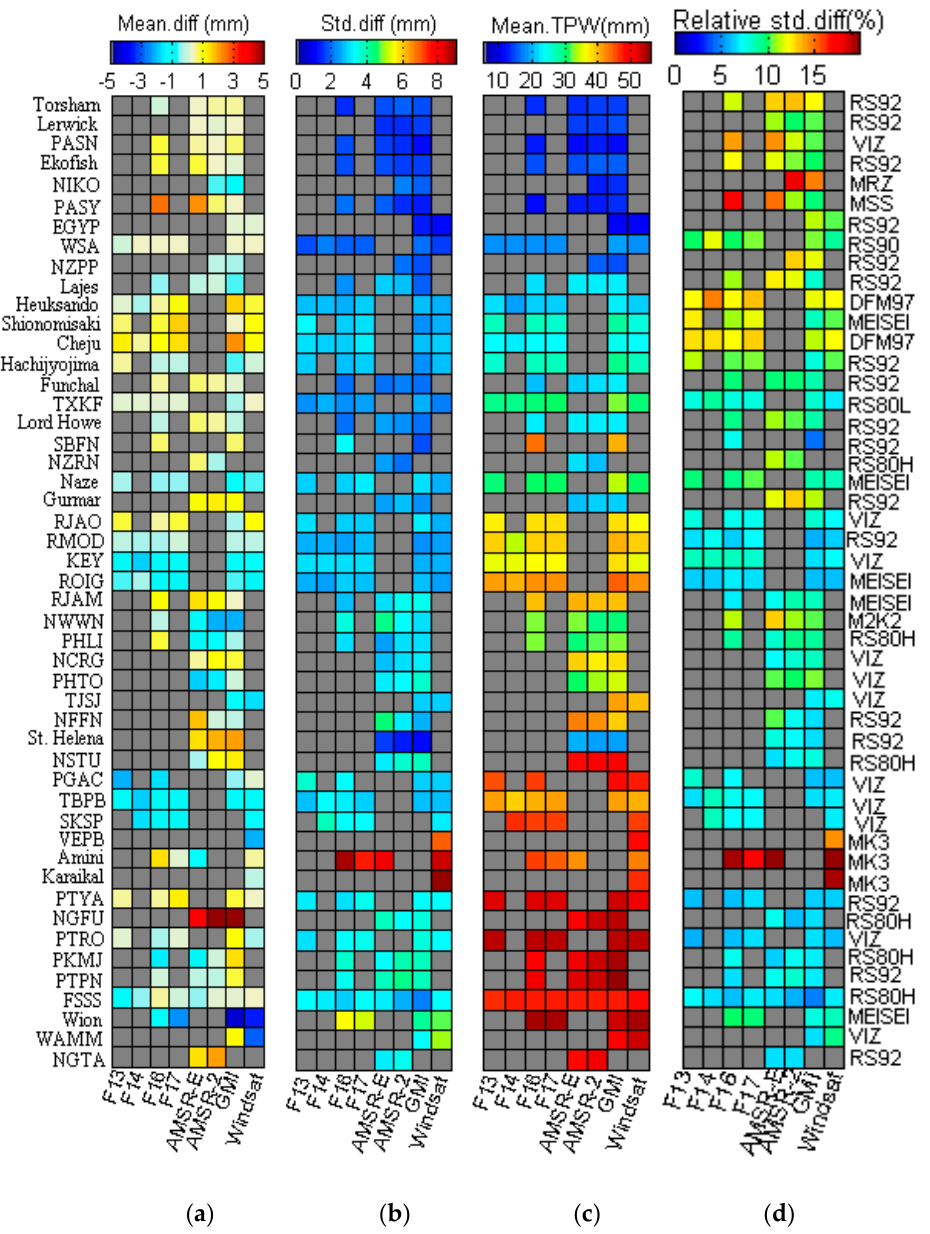
Figure 4. Summary statistics for TPW differences and mean values for each satellite–radiosonde pair. ( a ) Mean values of the differences; ( b ) standard deviations of the differences; ( c ) mean values of the satellite TPW; ( d ) relative standard deviations of the differences.